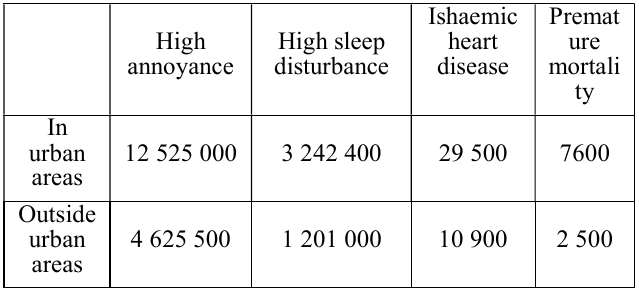
Table 3. Estimated number of persons suffering from different health outcomes due to road traffic noise, 2017,